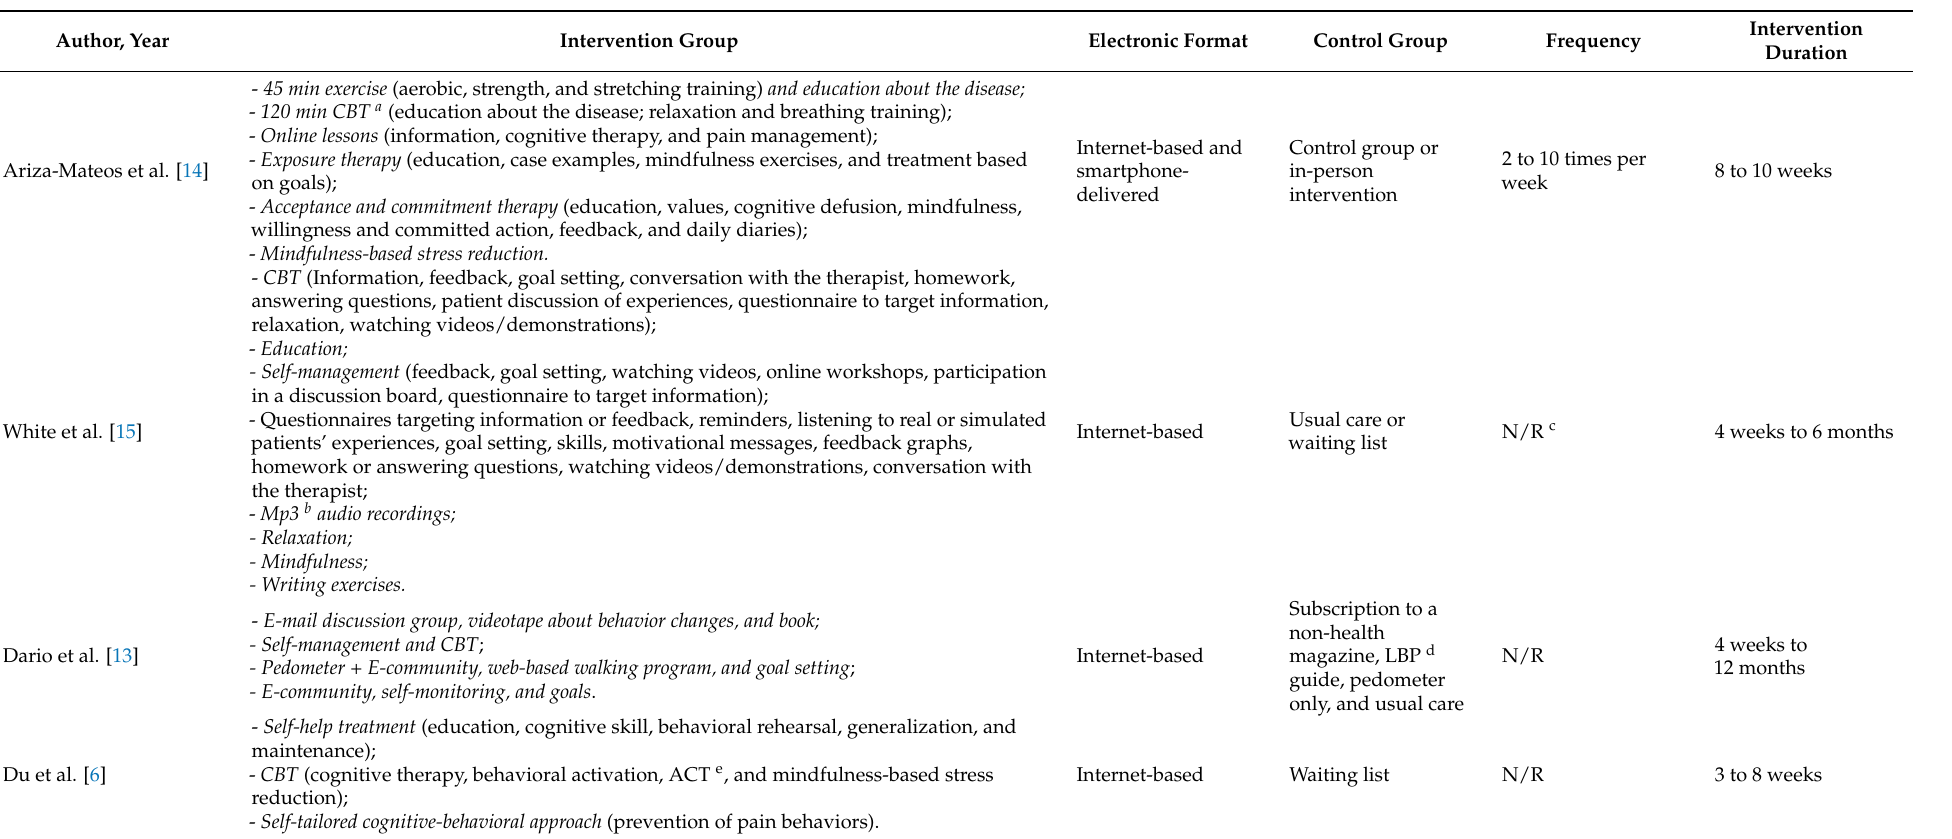
Table 2. Intervention